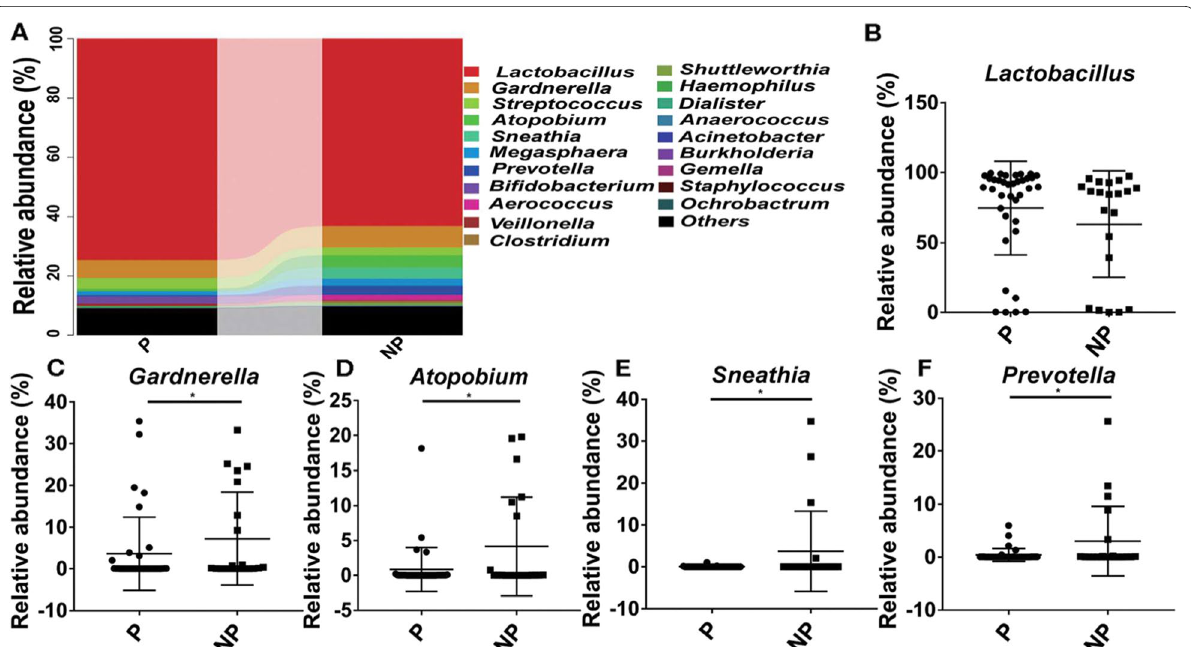
Fig. 5 At the genus level, the microbial community of the P and NP groups was compared. A In the P and NP samples, cumulative bar charts of the main taxa at the genus level. Lactobacillus ( B ), Gardnerella ( C ), Atopbium ( D ), Sneathia ( E ), Prevotella ( F ). P, pregnancy success after embryo transfer; NP, pregnancy failure after embryo transfer; *means P < 0.05, p < 0.05 indicates significant